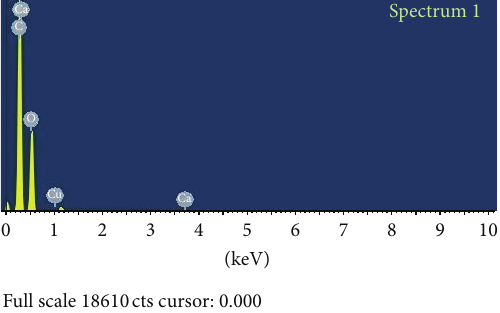
Figure 1: FTIR spectra of (a) CaHBSD and (b) copper loaded CaHBSD.